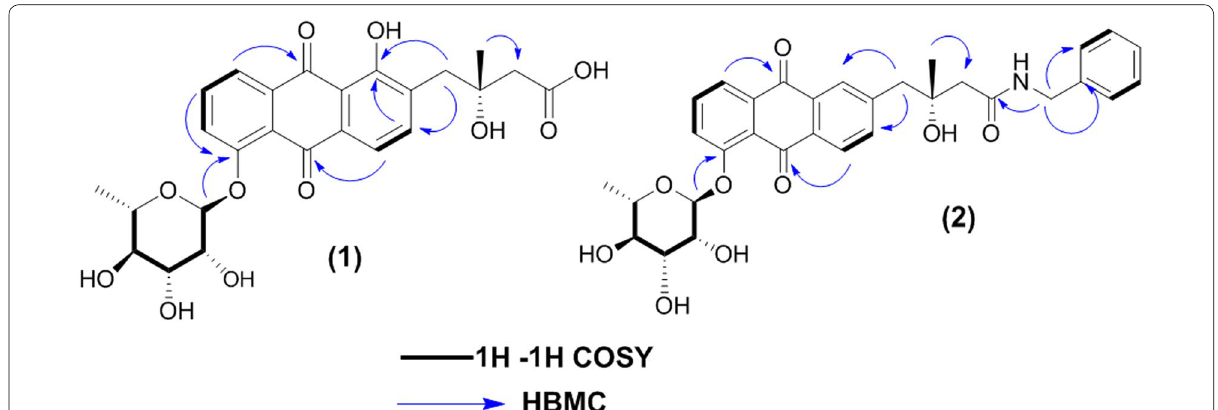
Fig. 4 Key COSY and HMBC correlations of fridamycin H (1) and I ( 2